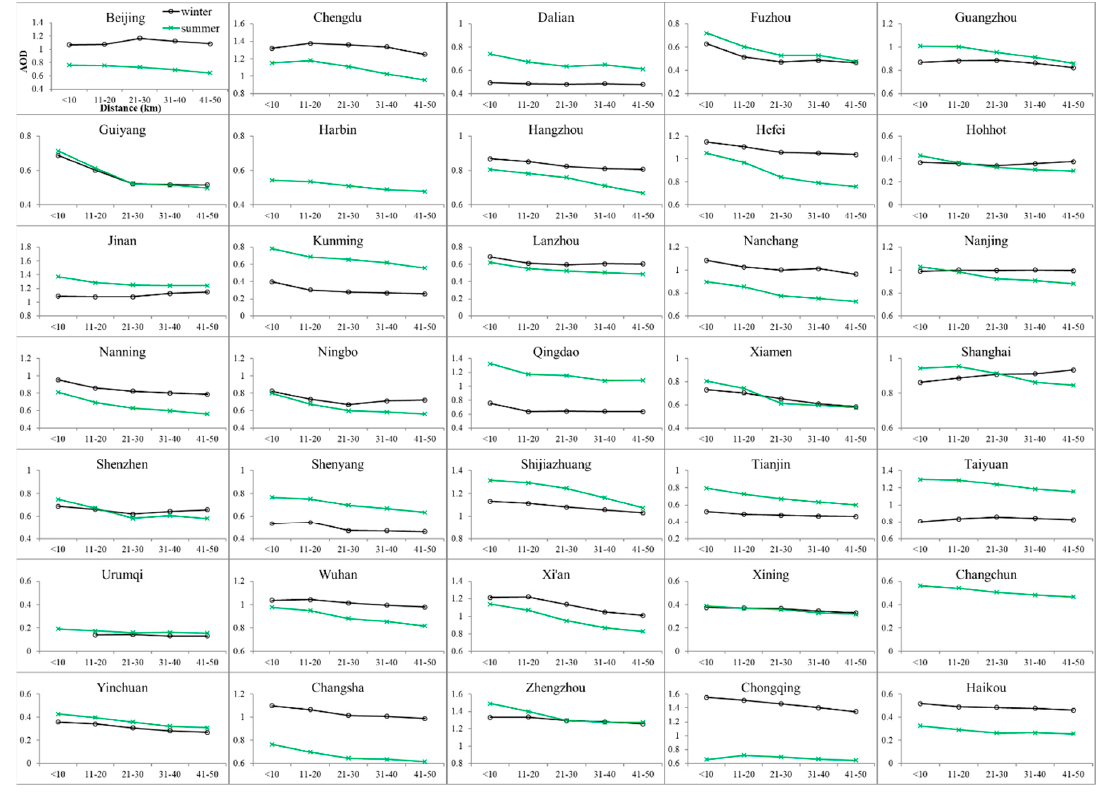
Figure 5. Mean AOD as a function of distance from the urban geometrical center of each city in winter (black curves with open circles) and summer (green curves with crosses). Note that wintertime AOD data are not available at cities Harbin and Changchun. The distance ranges are <10 km, 11–20 km, 21–31 km, 31–40 km, and 41–50 km from the urban geometrical center.